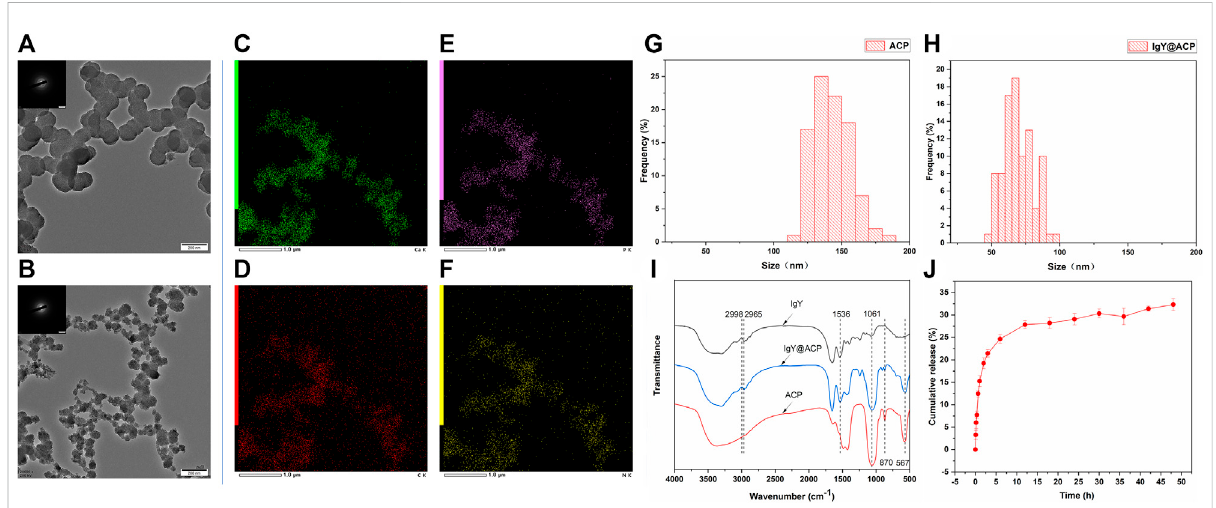
FIGURE 2 Characterization of ACP and IgY@ACP. TEM images of ACP (A) and IgY@ACP (B) . Element surface scanning of IgY@ACP (C – F) . Size distribution analysis of ACP (G) and IgY@ACP (H) . FTIR spectra of ACP, IgY, and IgY@ACP (I) . The release IgY protein curve of IgY@ACP in PBS (J) .